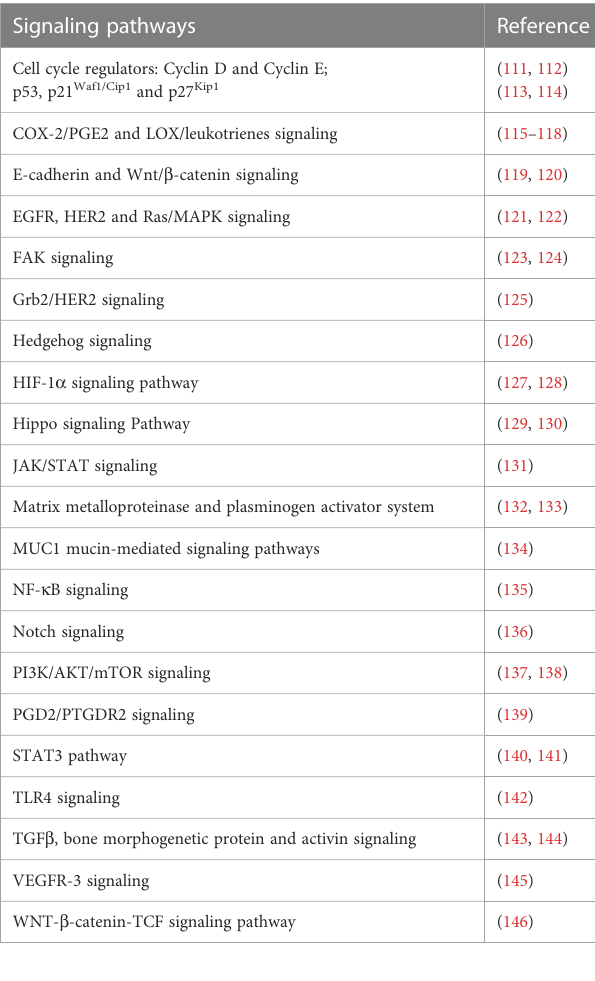
TABLE 2 A partial list of signaling pathways linked to oxidative stress in gastric